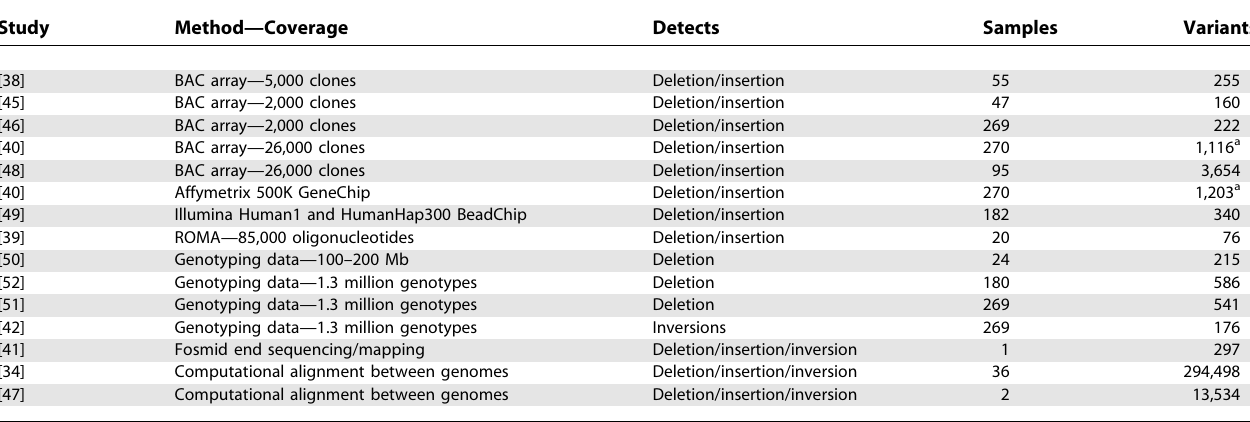
Table 2. Summary of Genome Scans to Study Structural Variations and CNVs of the Human Genome Study